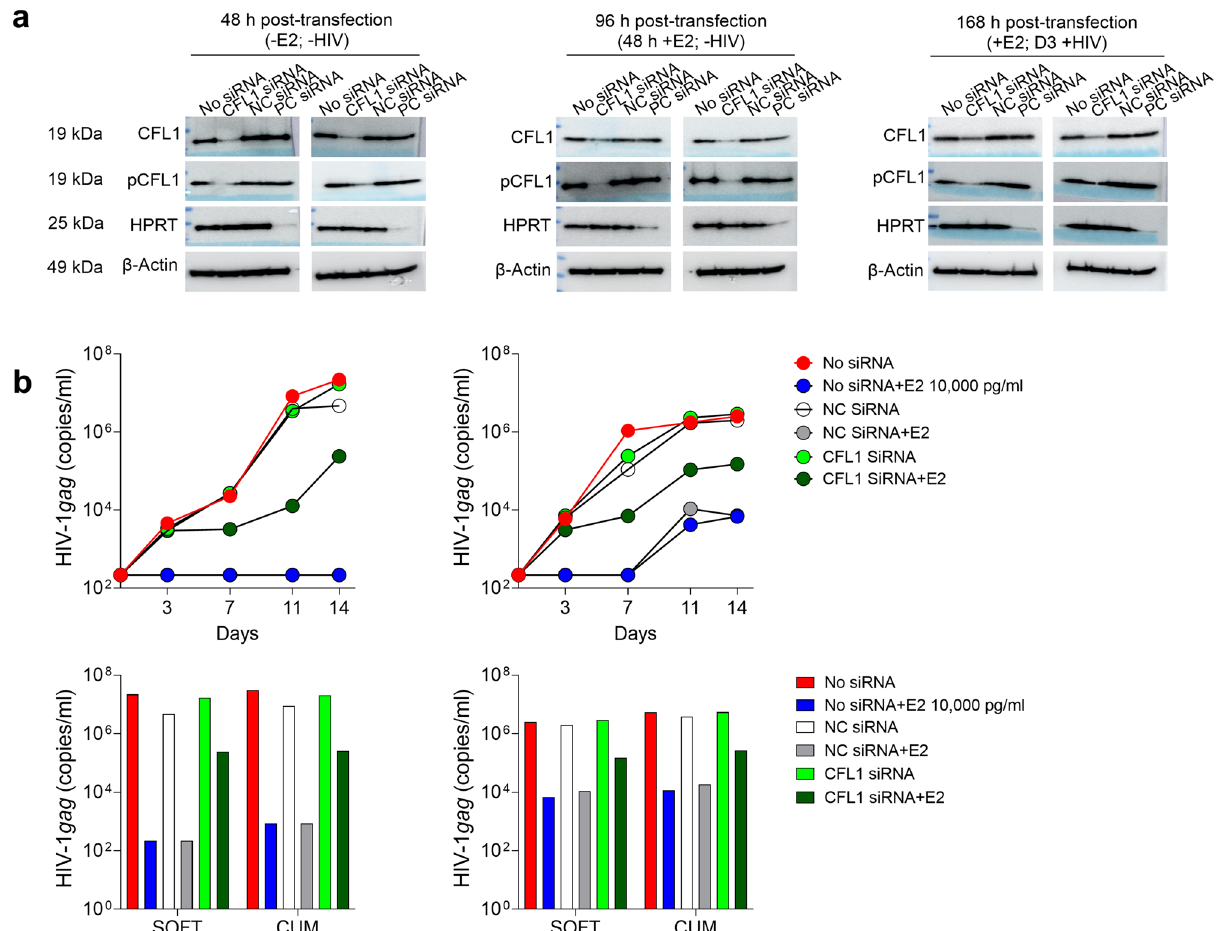
Figure 8. Knockdown of CFL1 reduces total CFL1 and pCFL1 expression in PBMCs and reverts E2-mediated anti-HIV-1 BaL activity in PBMCs. (a) PBMCs (10 6 cells/ml) were transfected with CFL1 siRNA, Trilencer-27 Universal scrambled negative control siRNA duplex and Trilencer-27 HPRT Positive control siRNA duplex using Viromer Green transfection reagent. 48 h post-transfection, PBMCs were split in two groups and either incubated with E2 10,000 pg/ml for additional 48 h or left untreated. 96 h post-transfection, PBMCs were challenged with 1000 TCID 50 /10 6 cells HIV-1 BaL and cultured for 3 days. WB analysis was done at 48 h, 96 h and 168 h post-transfection (2 experiments). WCEs (120 µg) were prepared at indicated time points and probed for CFL1 and pCFL1. β-actin (120 µg) was used as internal control. Uncropped blots are presented in Supplementary Fig. S8. ( b ) Transfected PBMCs were incubated with or without E2 10,000 pg/ml for 48